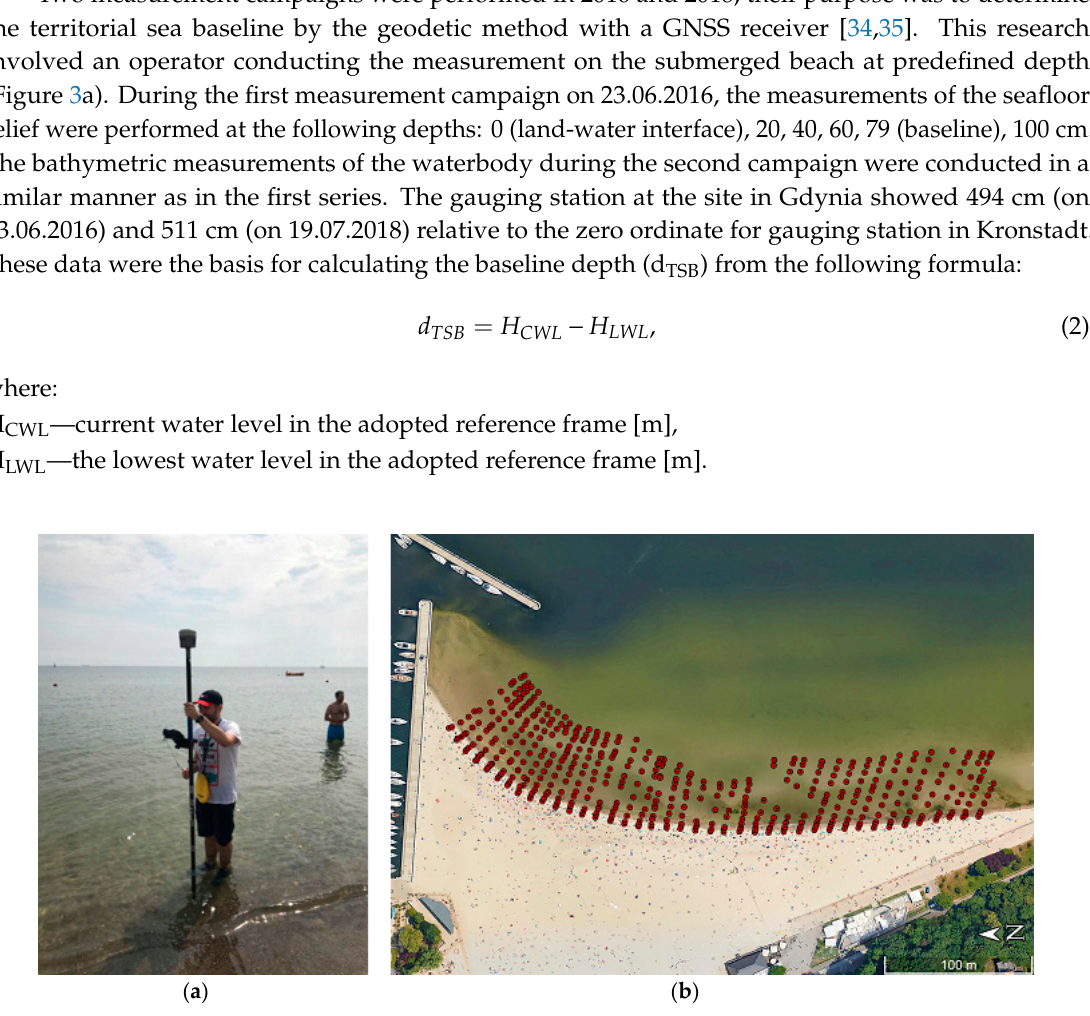
Figure 3. Territorial sea baseline measurement ( a ) and recorded measurement points ( b ) by the geodetic method during the second measurement campaign.